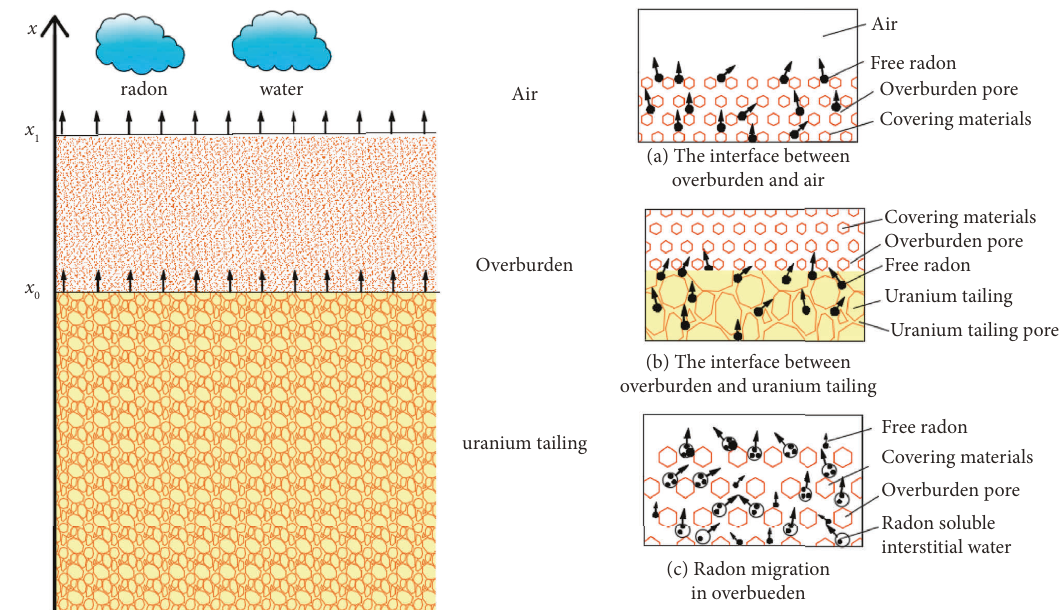
Figure 1: Radon migration model of the UMTs’ pond beach